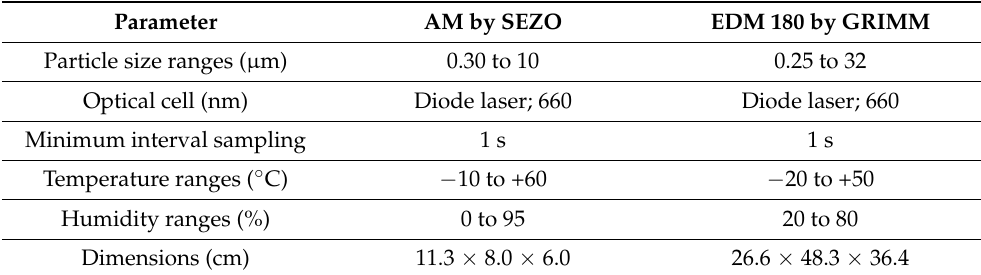
Table 1. Basic specification of AM and EDM 180 devices .